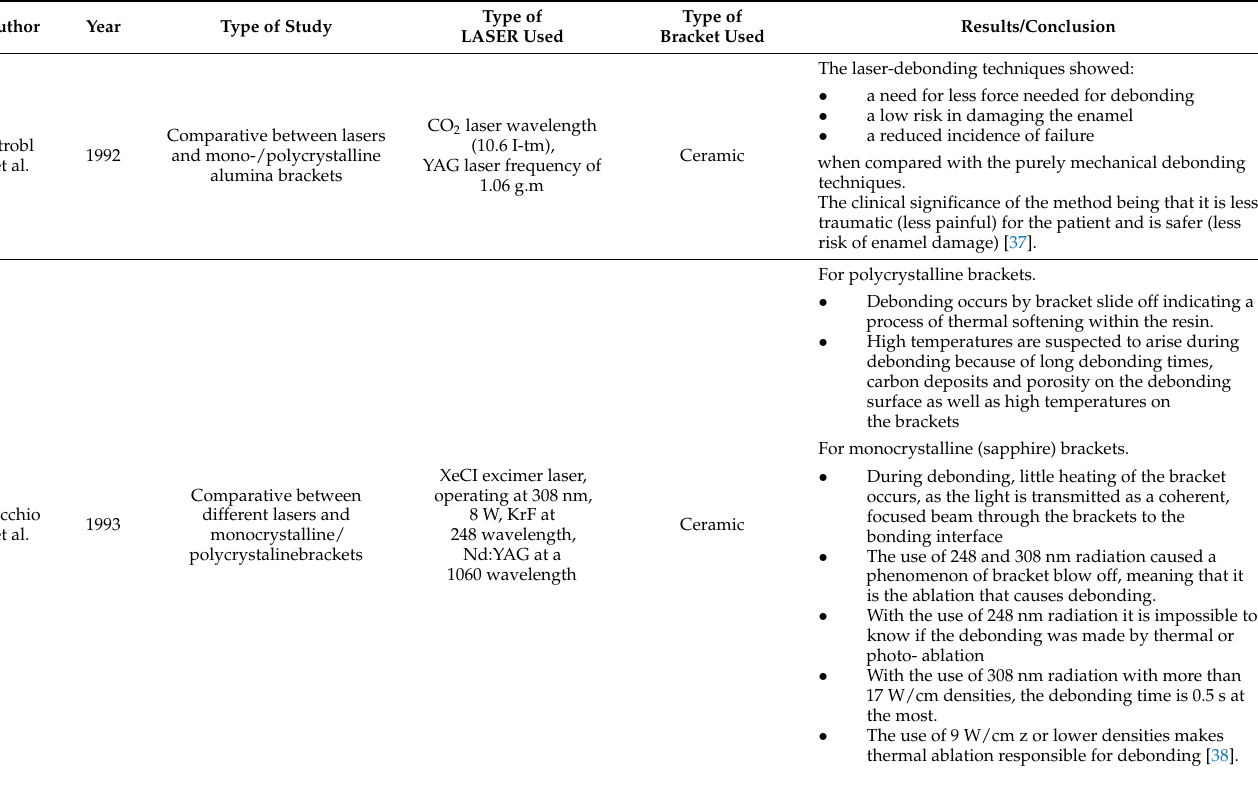
Table 4. Comparative Studies between different types of laser